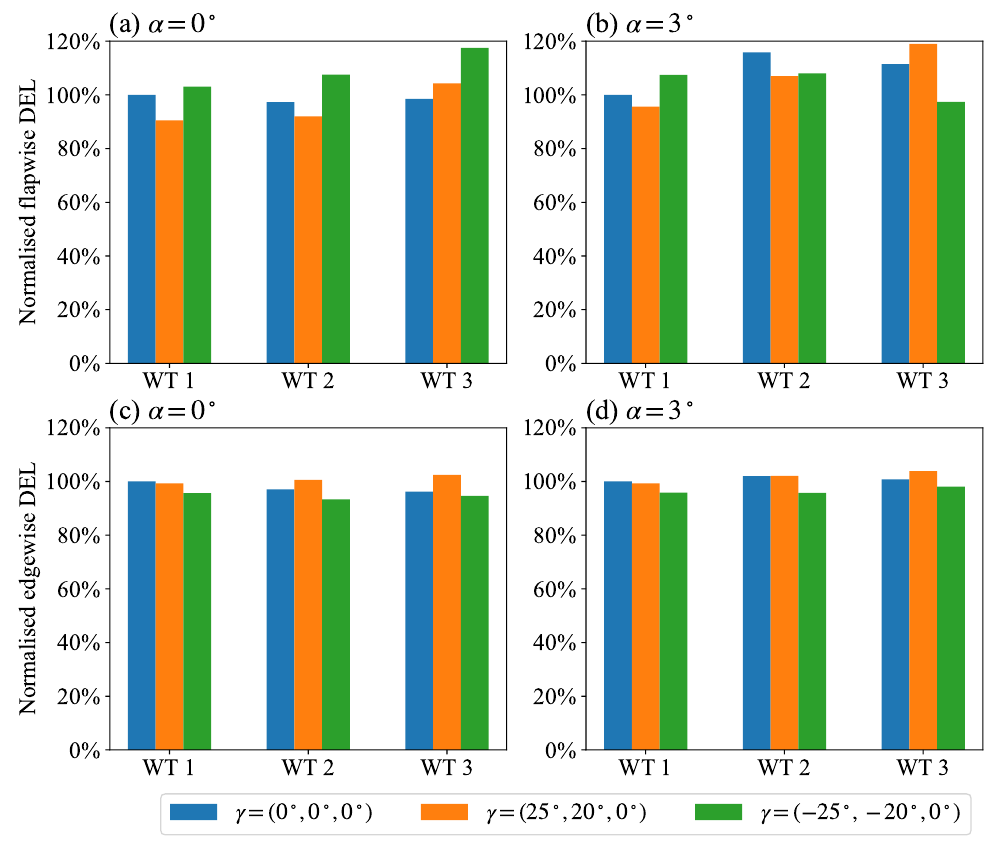
Figure 9. Normalised DELs of blade-root blending moments in different AYC configurations and inflow angles, normalised by the DELs of WT 1 in zero yaw conditions: ( a , b ) flapwise bending moment and ( c , d ) edgewise bending moment.